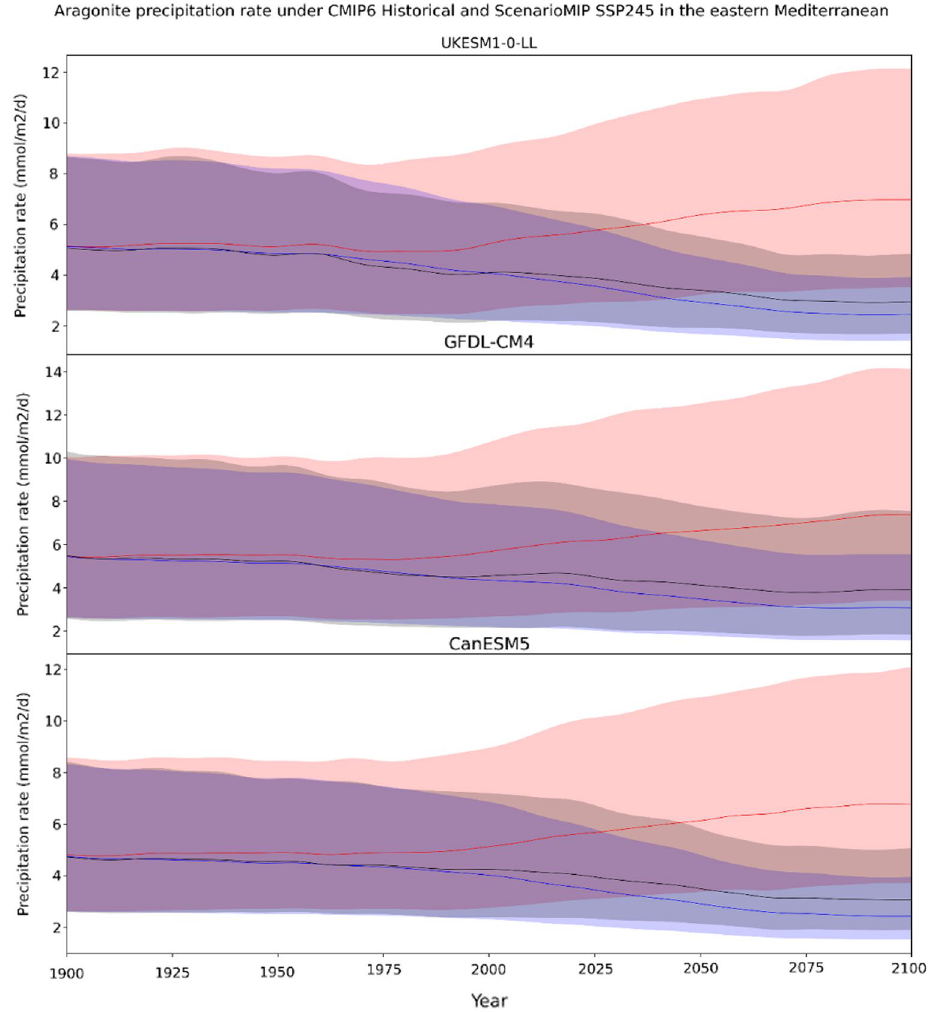
Figure 5. The change in R ai (abiotic aragonite precipitation rate) over time from model simulations. R ai (black (cid:31) − only SST − only R line), R ai (red line) and ai (blue line) from CMIP6 Historical and ScenarioMIP SSP2-4.5 for the eastern Mediterranean. The R ai scenario reflects the ‘true’ CMIP prediction, whereas the R scenarios fix (cid:31) Ar and SST, respectively to 1850–1899 climatological values. The top, central and bottom panels are UKESM1-0-LL, GFDL-CM4, and CanESM5, respectively. Shaded area indicate the range of error while the lines represents the annual mean (of monthly mean R ai calculated across the eastern Mediterranean) and the shaded region spans the annual